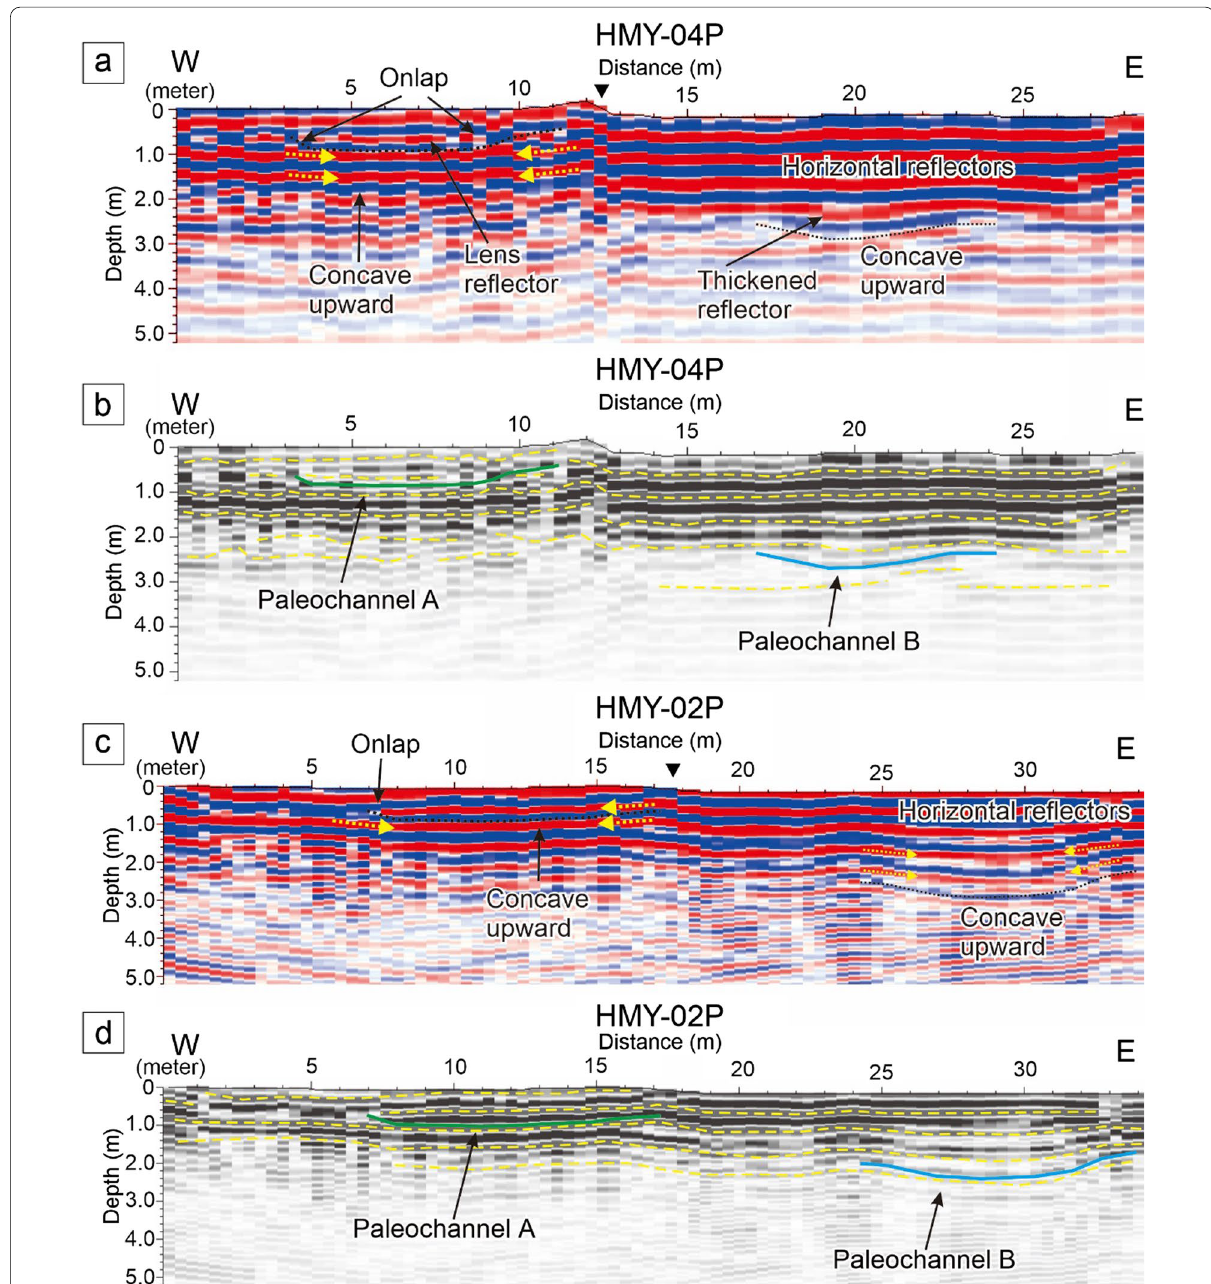
Fig. 6 a Processed GPR section of the HMY-04P. b Interpretation of the HMY-04P. c Processed GPR section of the HMY-02P. d Interpretation of the HMY-02P. The dashed yellow line indicates the trace of reflectors. The yellow dotted arrow indicates the dip of reflectors. Black triangles mark the concrete structures at the